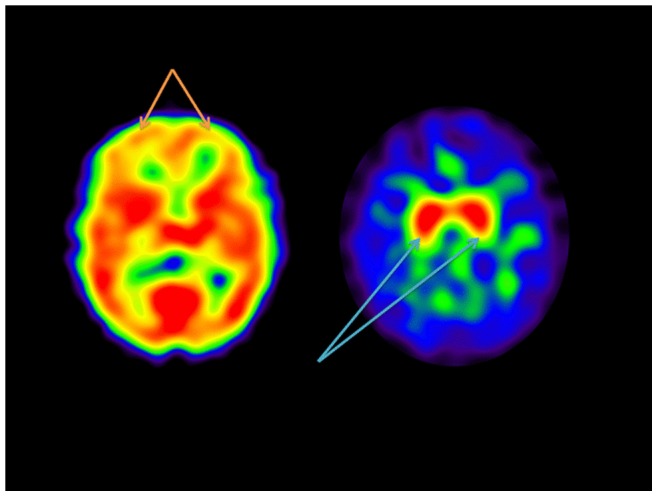

99mTc Exametazime and 123I Ioflupane SPECT studies in a 61 year old male subject with multiple prior TBIs presenting with headache and memory loss.Note the markedly decreased CBF primarily in the frontal lobes bilaterally (yellow arrows). However, this same patient had robust DAT binding in the striatum (blue arrows) with no significant abnormalities.